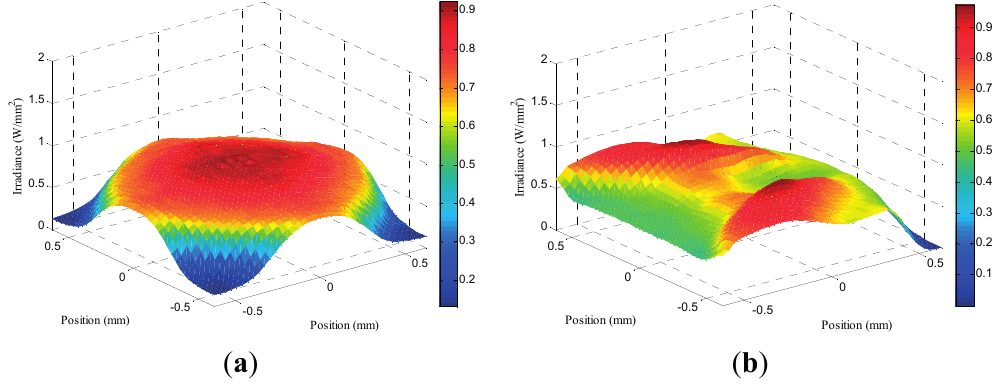
Figure 23. Irradiance distribution on the receiver from broadband simulation for the Fresnel lens with KOD II-type SOE ( a ) under normal incidence; ( b ) incidence angle =